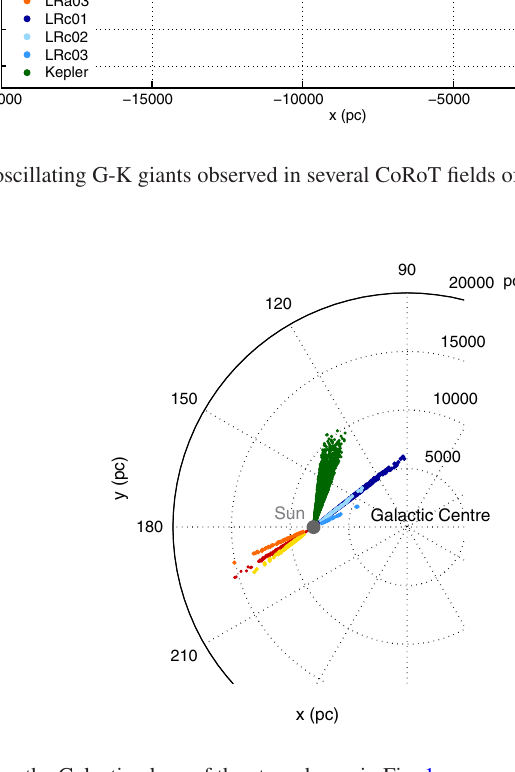
Figure 2. Projection on the Galactic plane of the stars shown in Fig. 1.